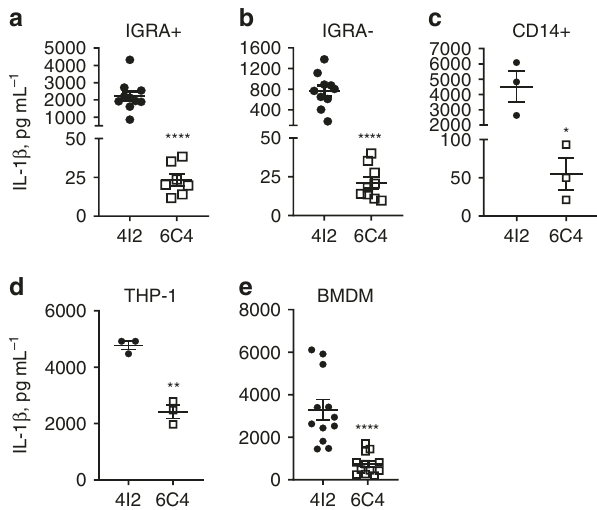
Fig. 3 M . tuberculosis manipulate IL-1 β induction independent of host TB status. M . tuberculosis isolates 4I2 and 6C4 were selected based on the TB presentation, MTBC sublineage and intensity of cytokine induction in infected PBMCs. PBMCs from IGRA + ( a ) or IGRA – ( b ) donors; CD14 + monocytes puri fi ed from IGRA – donors ( c ); PMA-differentiated THP-1 cells ( d ) or C57BL/6 mouse BMDMs ( e ) were infected with M . tuberculosis isolate 4I2 (solid circles or bars) or 6C4 (open squares or bars) for 24 h and the amount of secreted IL-1 β quanti fi ed in the culture supernatants by immunoassay. MOIs of 1 ( a – d ) or 2 ( e ) were used for infection. Represented is the mean ± SEM; n = 10 donors ( a , b ), or n = 3 donors ( c ) or n = 3 wells from one ( d ) or four ( e ) independent experiments. Undetected values are not represented. Statistical analysis was performed using two- tailed unpaired Student ’ s t -test (* p < 0.05; ** p < 0.01; *** p < 0.001; and **** p <